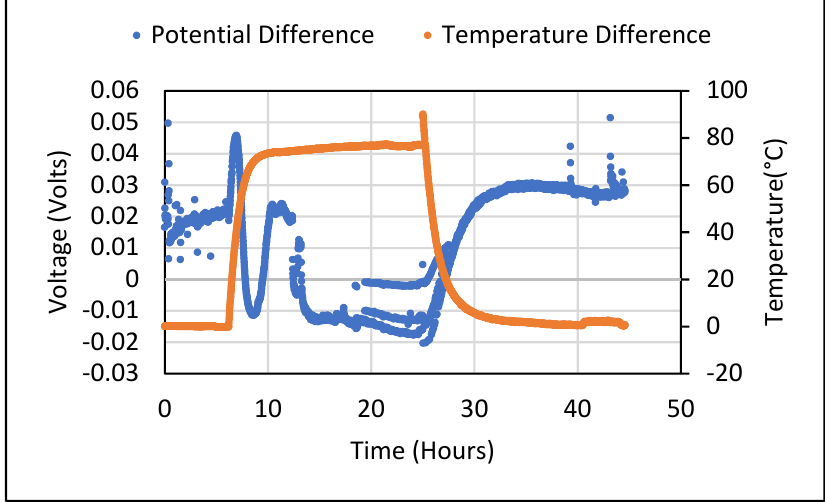
Figure 5. Voltage difference obtained from 5%wt. Bi 2 O 3 cement composite at constant temperature difference.